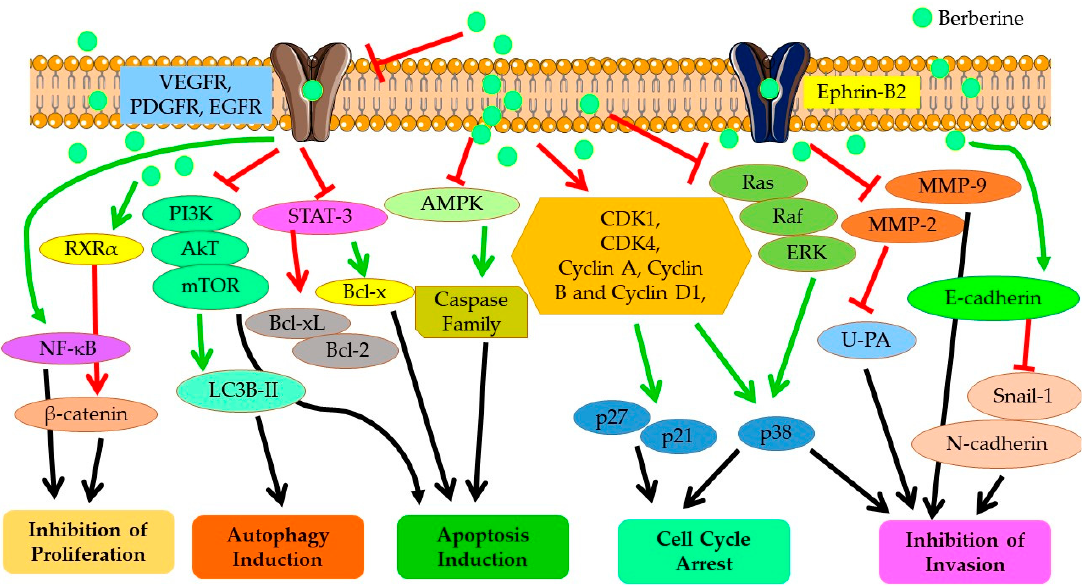
Figure 4. Anticancer mechanisms and signaling pathways regulated by Berberine. Red line shows inhibition/reduction, green line shows promotion/induction.